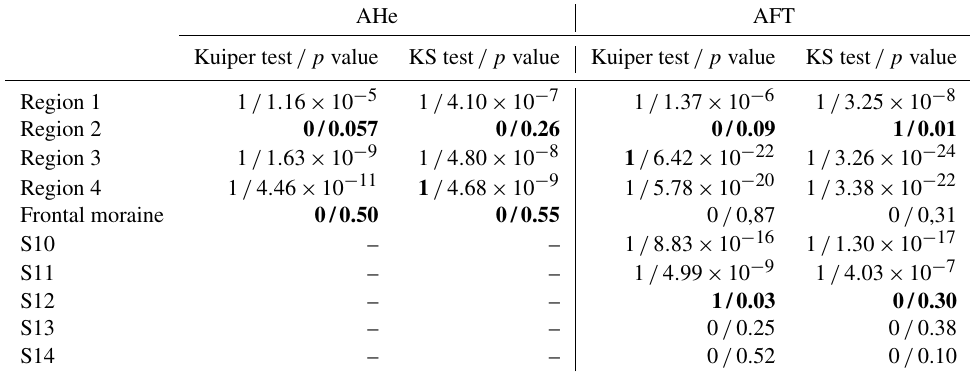
Table A1. Statistical test results from Kuiper and Kolmogorov–Smirnov (KS) tests, with associated p values for the modelled detrital CSPDFs shown in Sect. 4.4. Each modelled detrital CSPDF (regions 1–4 and frontal moraine) is tested against the modelled catchment bedrock CSPDF. “Frontal moraine” corresponds to the mean detrital CSPDF of the entire moraine. The variability of detrital SPDFs of the original data from Enkelmann and Ehlers (2015), p values for S10–S14, has been tested by comparing the original ice-cored detrital SPDFs against the detrital age distribution of the glacial outwash sample (9TETG15) presented in Ehlers et al. (2015). Highlighted in black are contradictions or p values close to the alpha level (0.05) between the two statistical tests about the similarity between the corresponding detrital CSPDF and the catchment bedrock CSPDF (or glacial outwash in case of S10–S14). 1: the two distributions are different, 0: the two distributions are similar.